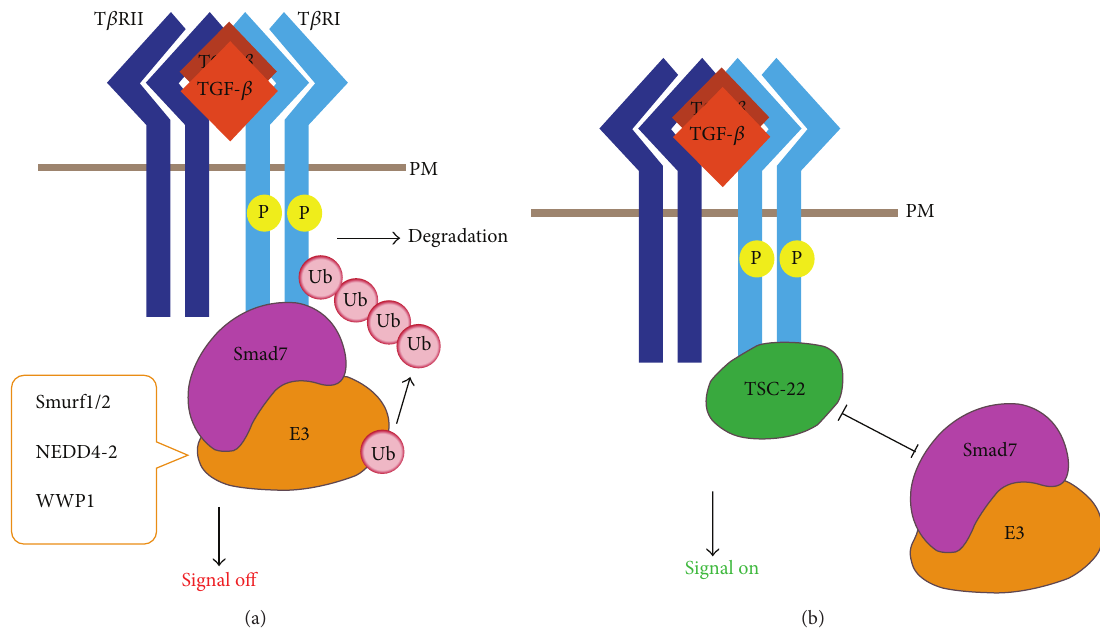
Figure 2: Regulation of TGF- 𝛽 receptor degradation and expression. (a) TGF- 𝛽 receptors localized in lipid raft/caveolae and caveolin-1- positive vesicles undergo ubiquitination. Smad7 recruits HECT domain-containing E3 ligases to mediate ubiquitination and degradation of T 𝛽 RI. (b) TSC-22 competes with Smad7/Smurfs for T 𝛽 RI binding and therefore decreases the ubiquitination and degradation of the receptor, leading to enhanced TGF- 𝛽 signaling. PM: plasma